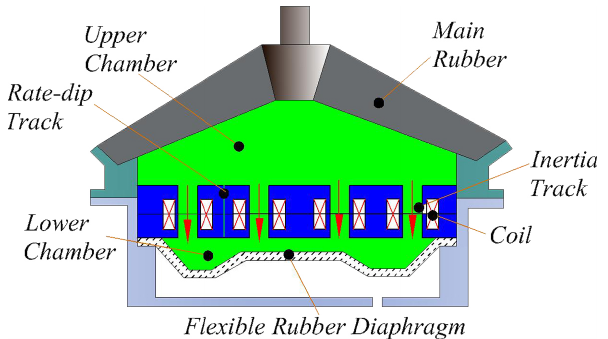
Figure 1. Schematic configuration of controllable multi-channel semi-active MR fluid